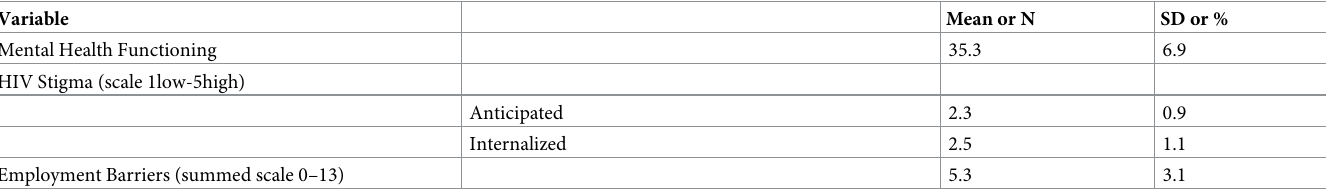
Nearly half (48.8%) reported their highest level of education as high school or less. A majority of participants reported being unemployed (80.1%) or underemployed (19.8%) and literally homeless (41.7%) or unstably housed/at risk of losing housing (44.9%). The aver- age reported scores of anticipated and internalized HIV stigma were 2.3 (SD 0.90) and 2.5 (SD 1.1), respectively. Most participants were virally suppressed (67.4%) and had health insurance (69.6%). Roughly, one-third of the sample reported being incarcerated at some point in their lives. Participants reported an average of 3.8 (SD 2.2) unmet needs out of a possible 13. Addi- tionally, participants reported 5.3 (SD 3.1) barriers to employment out of a possible 13. Inter- item reliability for the 13-item barriers to employment scale showed appropriate reliability (alpha = 0.75) [25]. All other average values of covariates are presented in Table 1. Results from the regression analyzes are presented in Table 2. First, we estimated and tested the unadjusted associations between anticipated and internalized stigma and employment bar- riers in Model 1. Anticipated stigma ( β = 0.19, p = 0.001) and internalized stigma ( β = 0.17, p = 0.002) were positively associated to employment barriers. Second, we estimated and tested the associations between anticipated and internalized stigma and employment barriers while adjusting for covariates. The results are presented in Model 2. After adjusting for covariates, anticipated stigma was significantly and positively associated with employment barriers ( β = 0.12, p = 0.04). After adjusting for covariates, inter- nalized stigma was not related to employment barriers ( β = 0.07, p = 0.25). Physical health functioning and mental health functioning also significantly predicted employment barriers ( β = -0.40, p < 0.001; β = -0.18, p < 0.001, respectively) with higher physical and mental health functioning being associated with fewer employment barriers. Model 1 and Model 2 significantly accounted for 8% and 20% of the total variation in employment barriers, respectively. Table 2. Relationship between stigma and employment barriers. Model 1. Unadjusted Associations between Stigma and Employment Barriers Parameter β